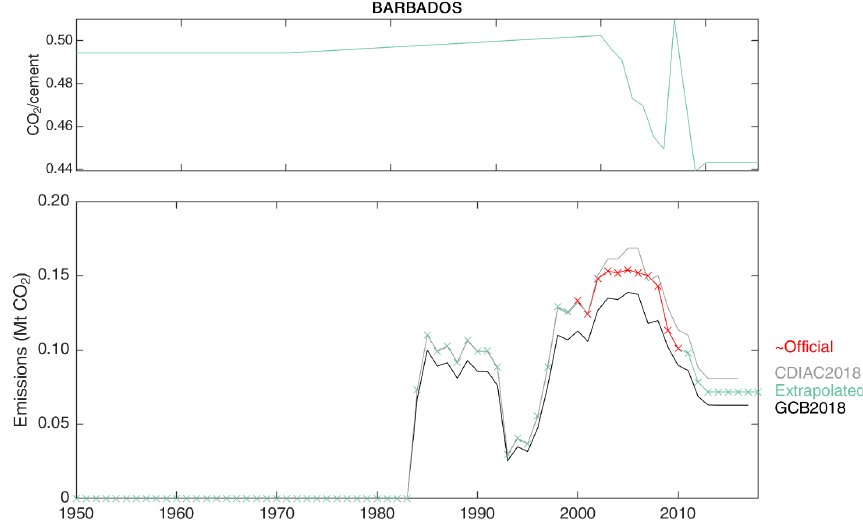
Figure C13. Revised cement emissions in Barbados.